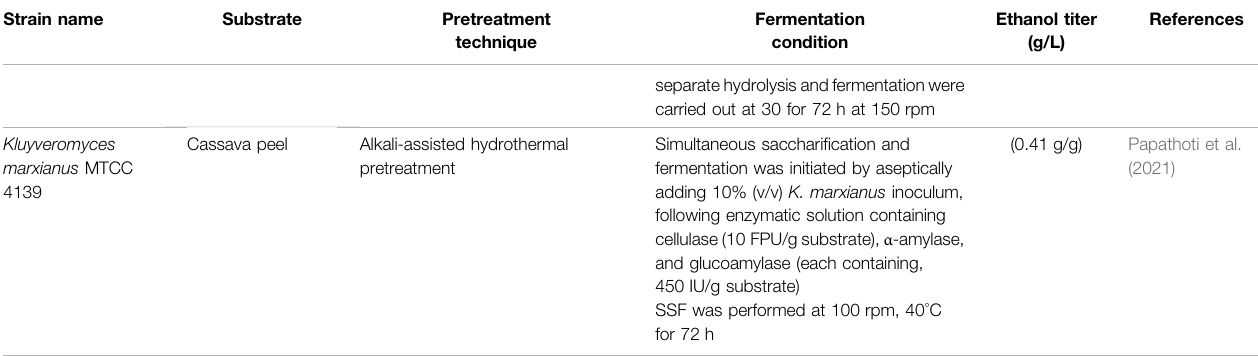
TABLE 2 | ( Continued ) Summary of ethanol production by various Kluyveromyces marxianus